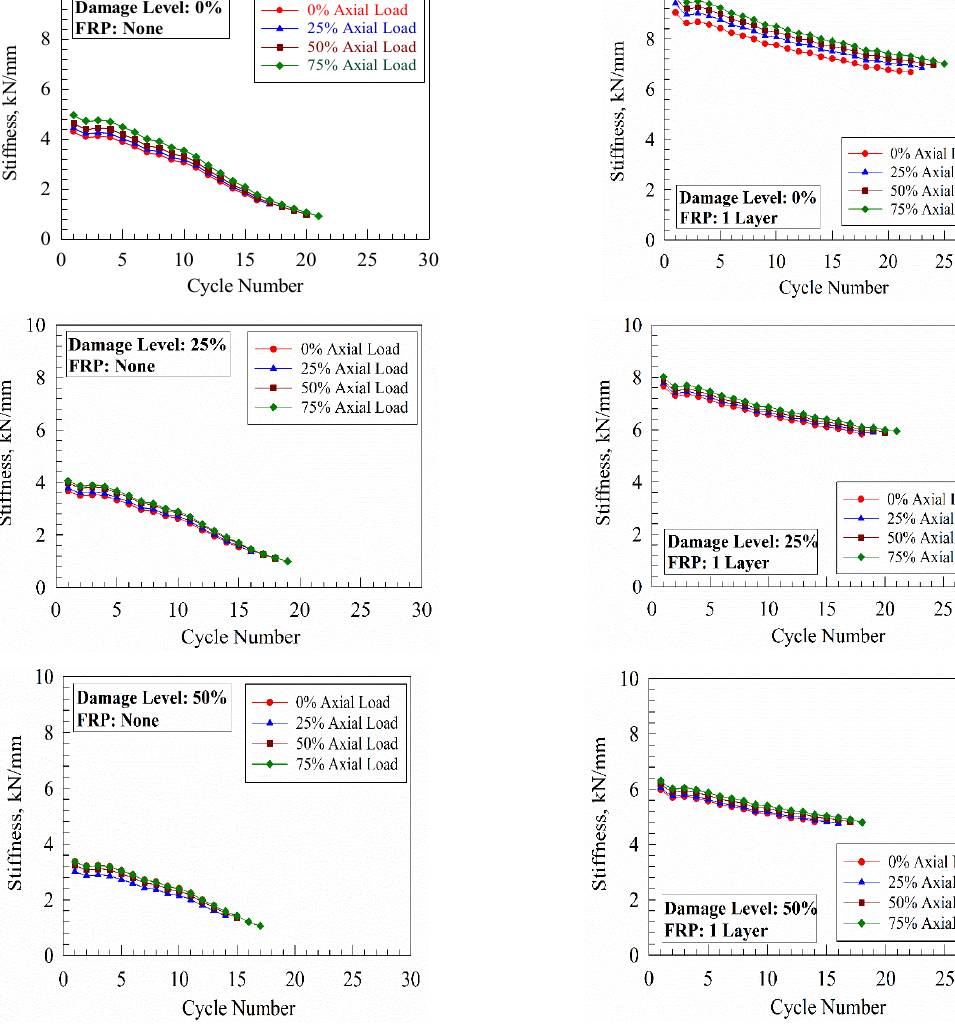
Figure 15. Stiffness degradation behavior. Meanwhile, dividing the energy dissipation value at the end of each cycle by 2 π times the elastic strain energy is generally known as the equivalent damping factor for the hysteresis loops, which is stored within a linear elastic system as per Equation (2) [64]: